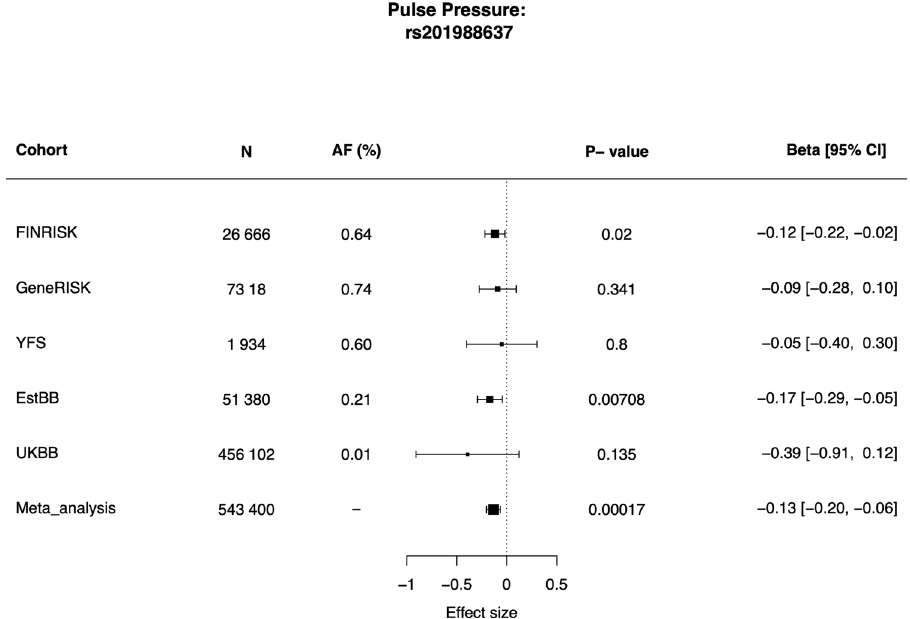
Fig. 7 Results for pulse pressure association across all cohorts with splice acceptor variant rs201988637 available (FINRISK, GeneRISK, YFS, EstBB, and UKBB). Size of the boxes represent the sample size of the cohorts, and the lines the 95% con fi dence interval. Associations were tested using linear regression, adjusting for age and sex Pulse pressure phenotypes were inverse-rank normalized prior analysis. Source data for the fi gure is in Supplementary Data 1.